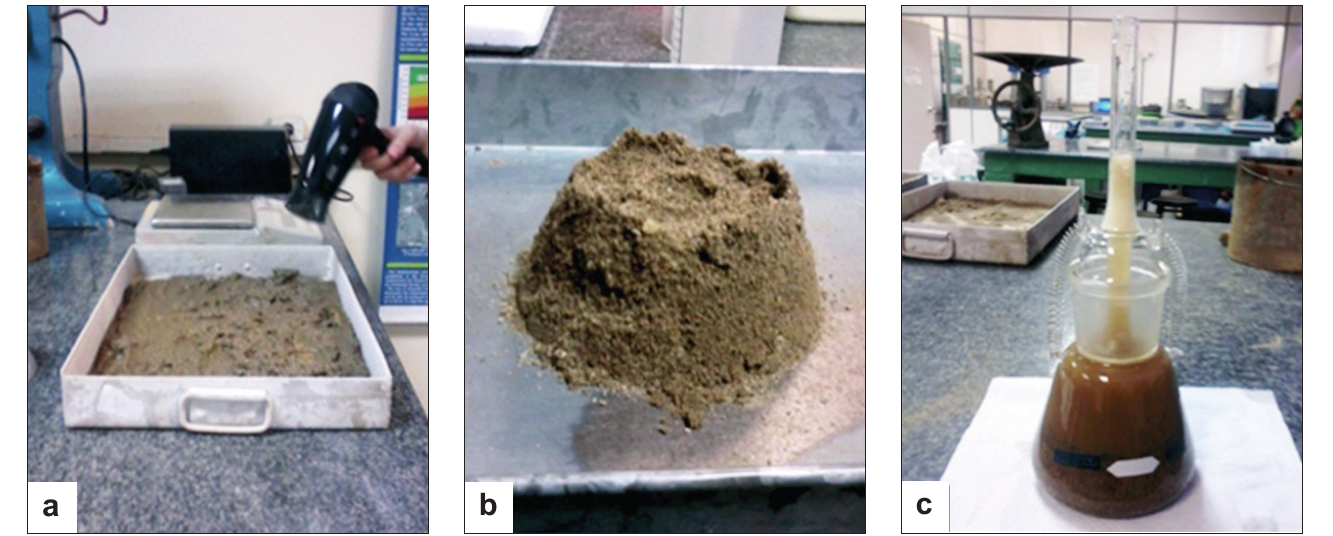
a b Test for determining the specific mass of the sand, (a) drying material by blowing air; (b) dry surface saturated condition; (c) calibrated flask with the sample after removing air bubbles